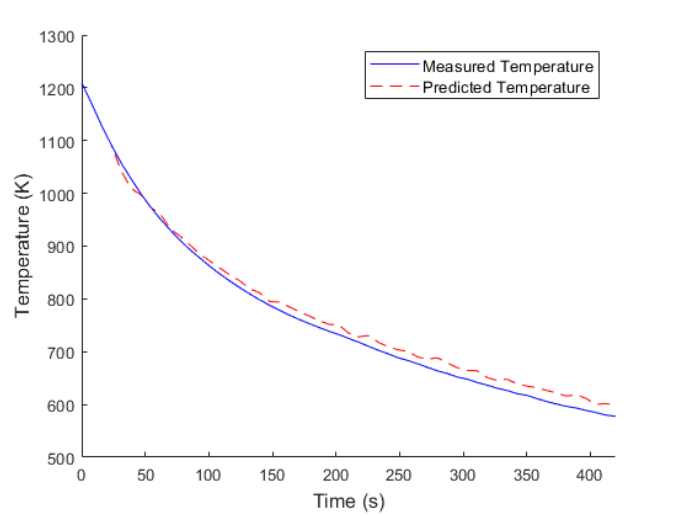
Figure 7. IR image showing actual temperatures ( a ) compared with an IR image overlaid with model predicted temperatures ( b ).